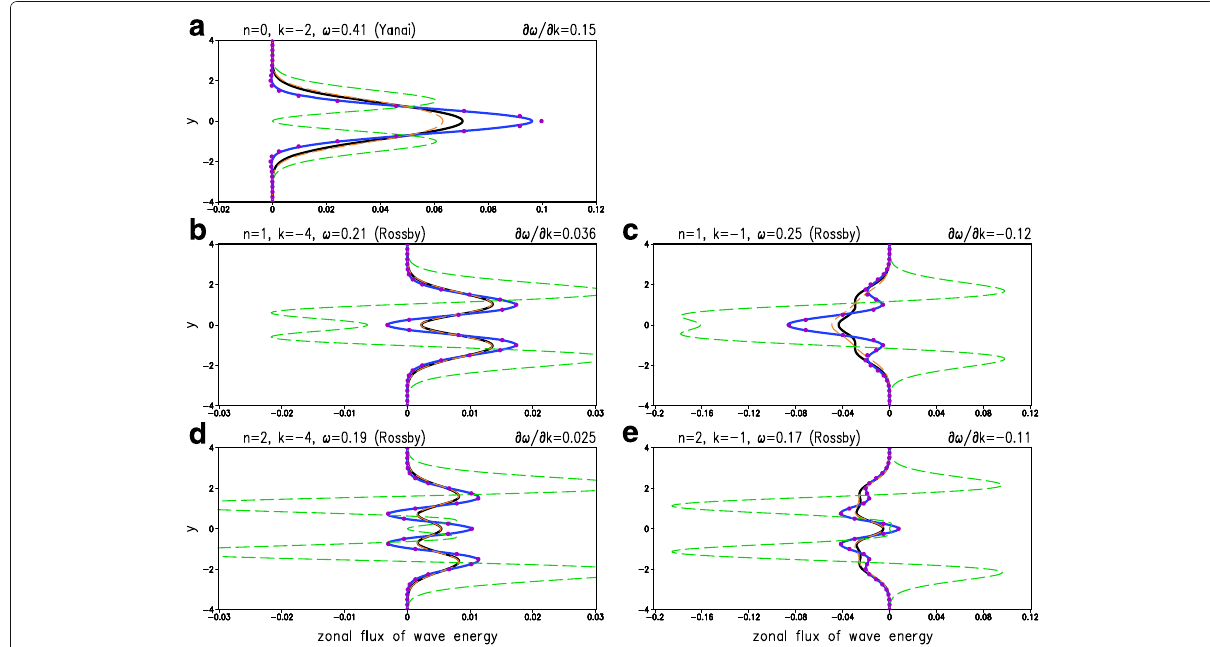
Fig. 2 Meridional profiles of the zonal component of phase-averaged energy flux associated with equatorial waves; the solidblackline is (∂ω/∂ k )( u 2 + v 2 + p 2 )/ 2, the dashedgreenline is up , the dashedorangeline is up + ( p ϕ app / 2 + u the purpledots are (ω/ k )( E − v 2 ) = (ω/ k )( u 2 − v 2 + p 2 )/ 2. All panels are for low-frequency equatorial waves with ω < 1: a westward propagating RGWs, b short and c long RWs in the 1st meridional mode, and d short and e long RWs in the 2nd meridional mode. The associated values of meridional-mode number n , zonal wavenumber k , wave frequency ω , and group velocity ∂ω/∂ k are noted in each panel. For each of a – e , the wave amplitude A in (11a) has been set to normalize the meridional integral of wave energy: